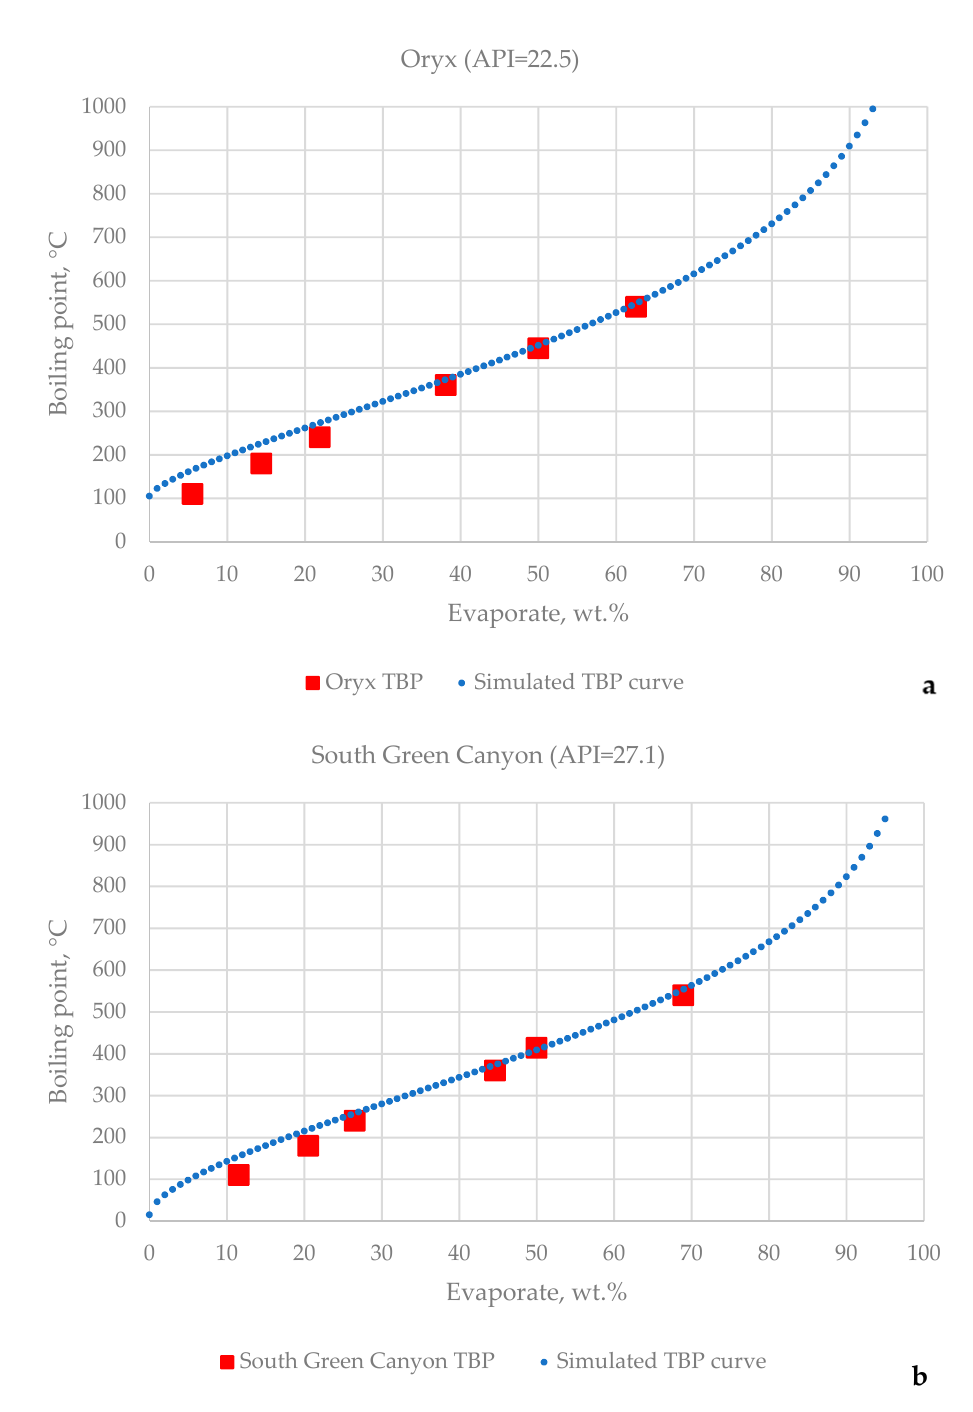
Figure 5. TBP curves of Oryx ( a ) and South Green Canyon ( b ) crude oils simulated with Equations (3)–(8) and Riazi’s distribution model (Equation (2)).